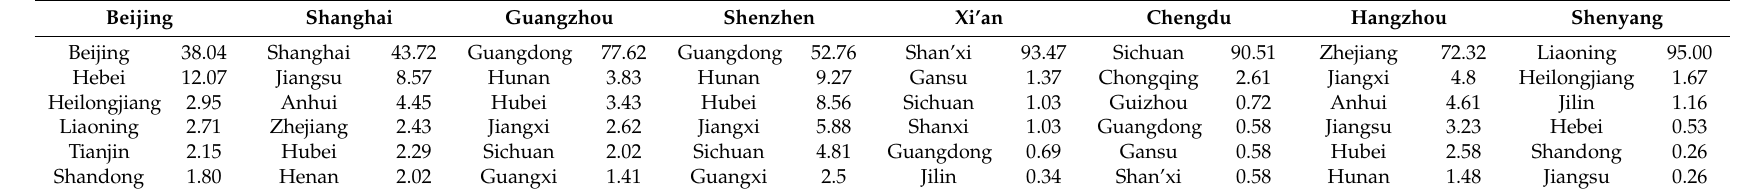
Table 2. hukou origination provinces of representative destination cities (in